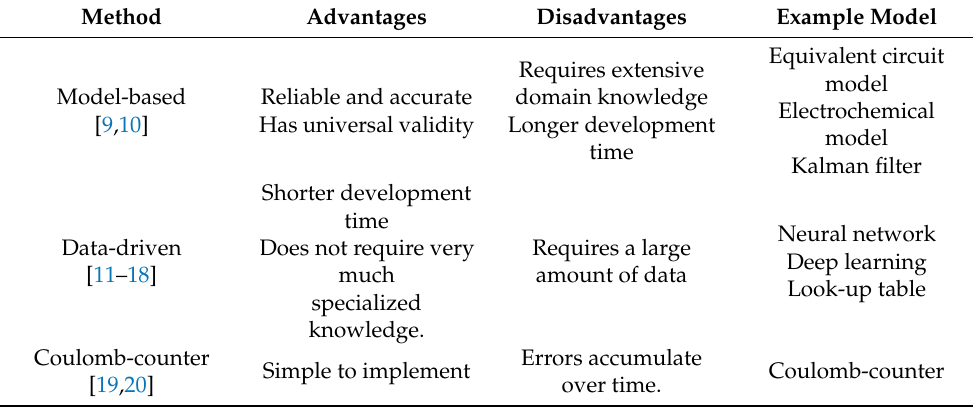
Table 1. Advantages and disadvantages of model-based, data-driven, and coulomb-counter methods.